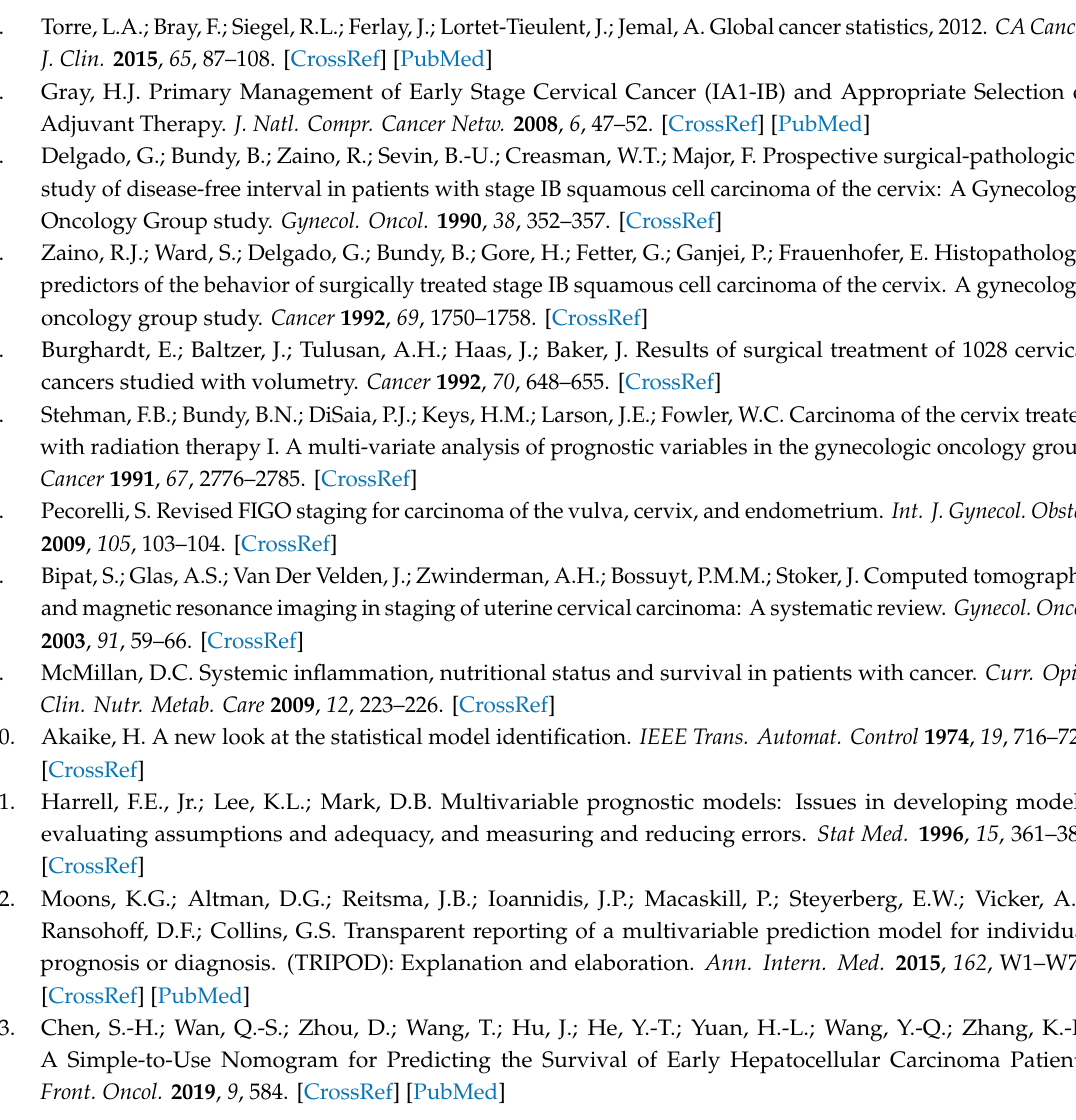
Table S1. Univariate analysis of disease-free survival by the Cox proportional hazard model. Table S2. Univariate analysis of hematogenous recurrence by the Cox proportional hazard